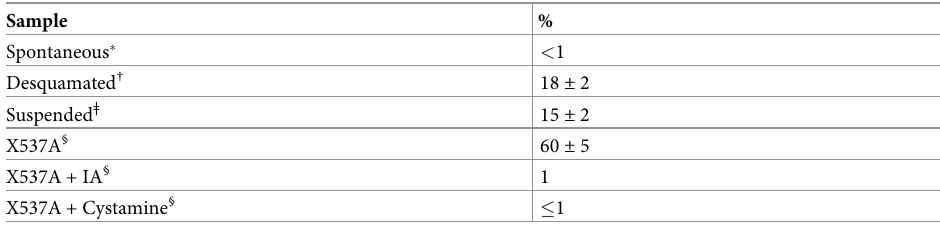
Table 1. Cross-linked envelope formation. Sample % Spontaneous � < 1 Desquamated † 18 ± 2 Suspended ǂ 15 ± 2 X537A § 60 ± 5 X537A + IA § 1 X537A + Cystamine § � 1 Cells were treated as described below, then counted after subsequent SDS/DTT treatment. � Confluent cultures treated directly with SDS/DTT. † Cells shed from confluent cultures and accumulating in the medium over 4 days. ǂ